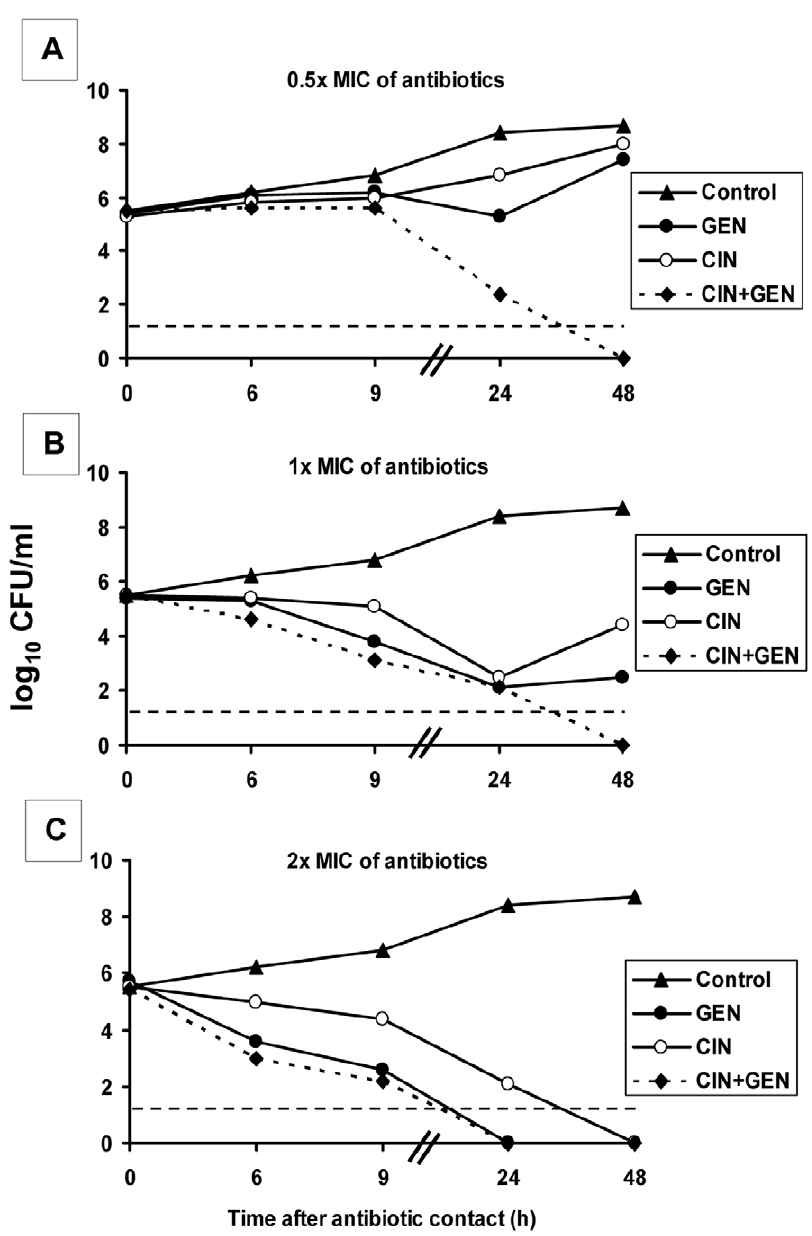
Figure 1. Activities of CIN and GEN in combination against Y.pestis CO92. CIN and GEN were respectively used at (A) 0.016 mg/L and 0.5 mg/L (0.5x MIC), (B) 0.032 mg/L and 1 mg/L (1x MIC) and (C) 0.064 mg/L and 2 mg/L (2x MIC). The dashed horizontal line indicates the LOD ( # 1.6 log 10 CFU).